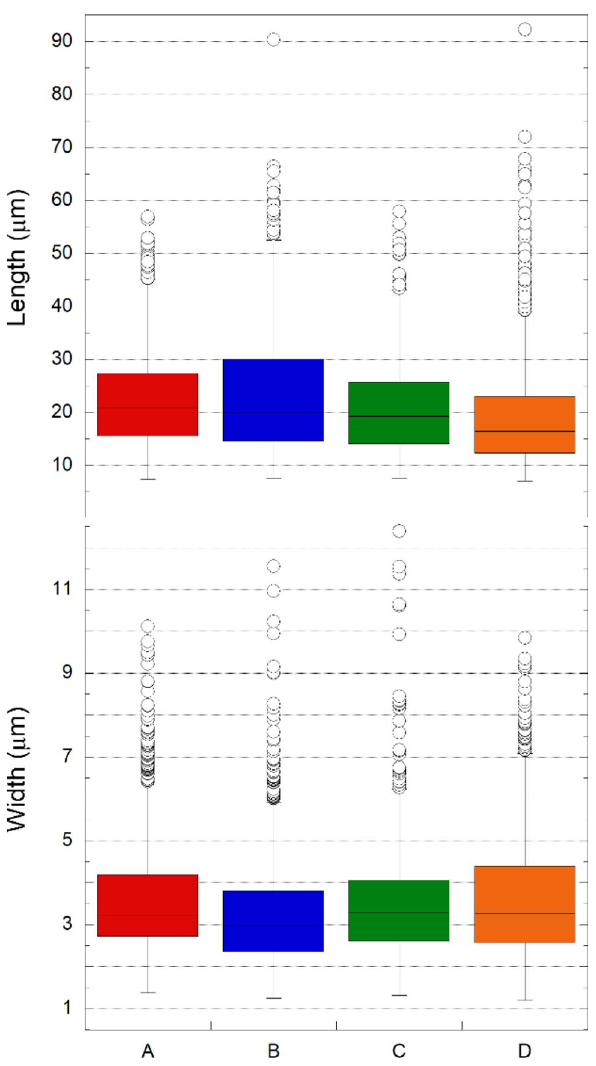
Figure 2. Box plots summarizing the distribution of the length (a) and width (b) values of the AB for samples A–C. Each box encloses 50% of the data with the median value of the variable displayed as a line. The top and bottom of the box mark the limits of ± 25% of the variable population (i.e. the Upper and Lower Quartiles, denoted as UpQ and LowQ, respectively). The lines extending from the top and bottom of each box mark the minimum and maximum values within the data set whose value is greater than UpQ + (1.5 × D U-L ) or less than LowQ − (1.5 × D U-L ), where D U-L is the distance between UpQ and LowQ. Any value outside of this range (outlier) is displayed as an individual